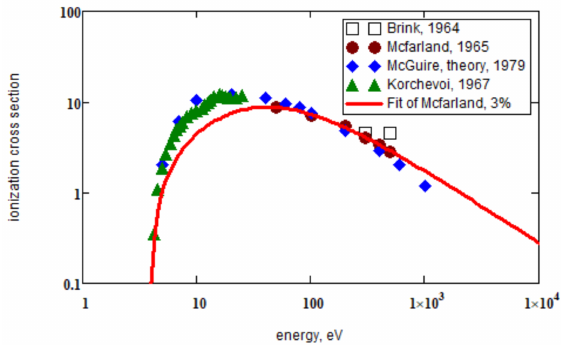
Figure 6. Electron impact ionization cross sections of cesium in Å 2